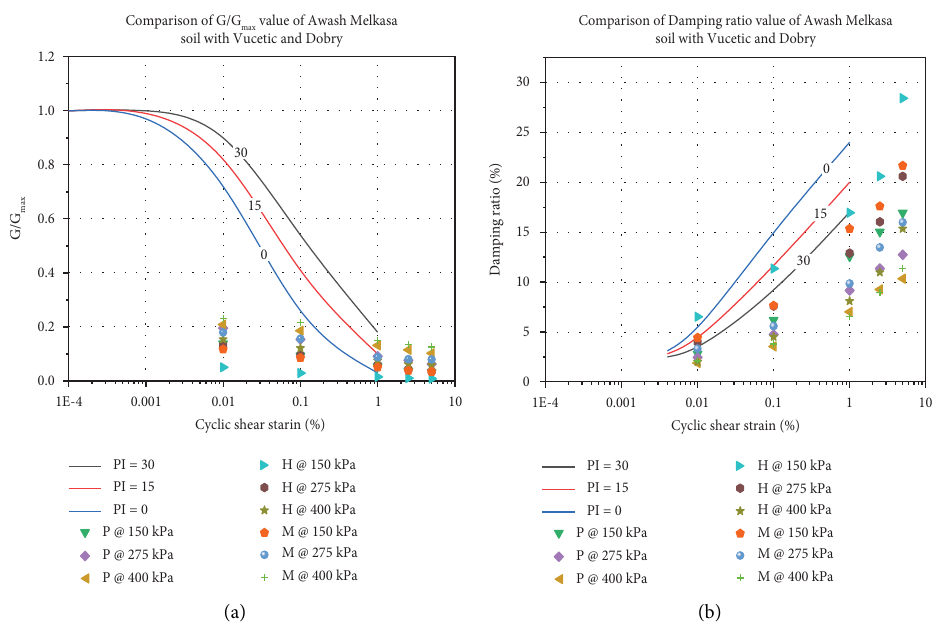
Figure 14: Comparison of Awash Melkasa soil with curves developed for plastic soils by Vucetic and Dobry: (a) G / G damping ratio values